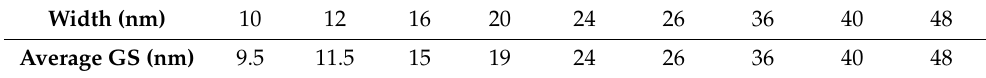
Table 2. Average grain sizes for Cu, Ru, Co, and W for simulations from Figures 4–6.